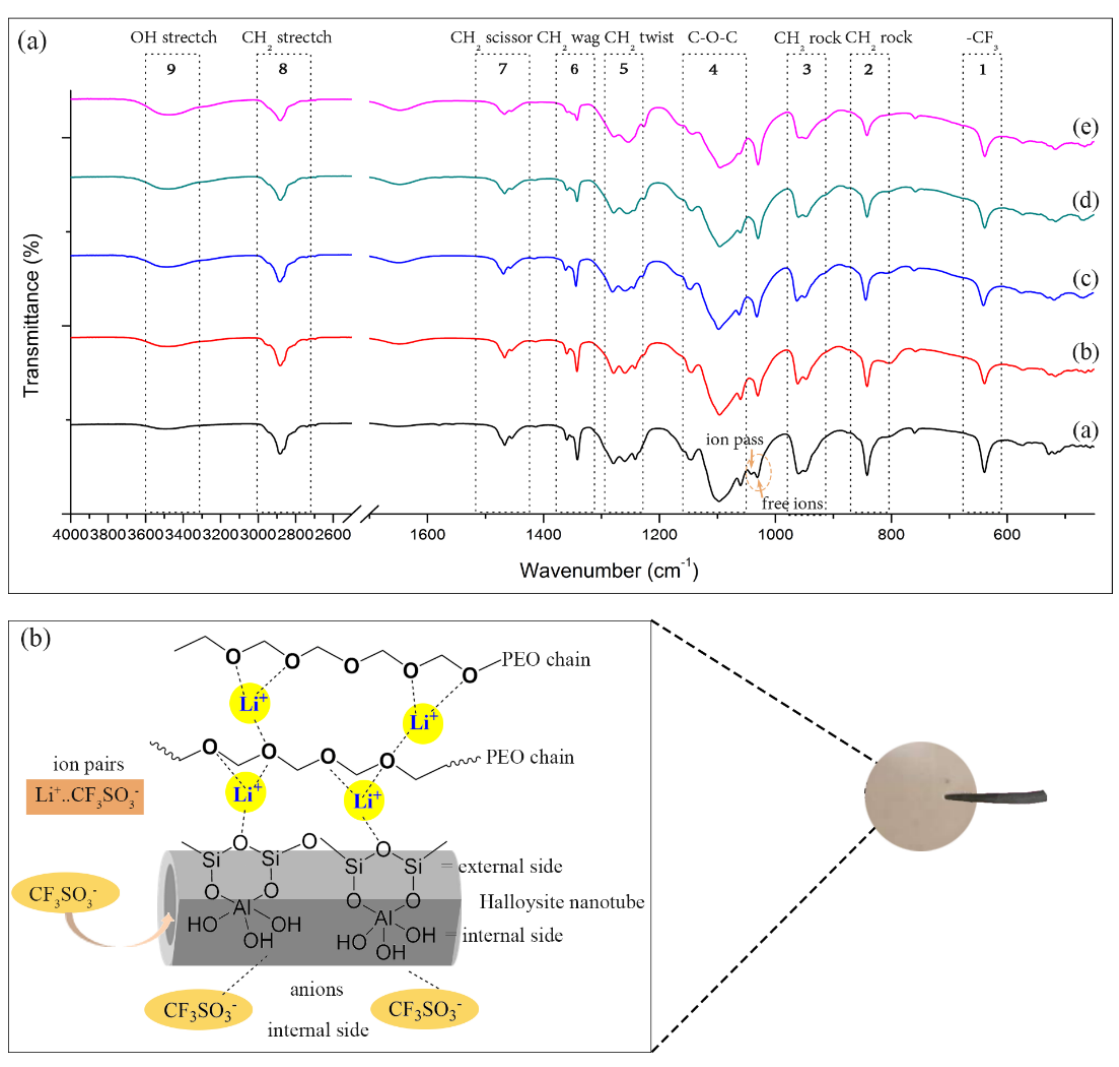
Figure 8. ( a ) ATR − FTIR spectra in the region of 450–4000 cm − 1 of (a) PEO − 20%LiCF 3 SO 3 , (b) PEO − 20%LiCF 3 SO 3 − 5%HNT, (c) PEO − 20%LiCF 3 SO 3 − 5%HNT − 15 min, (d) PEO − 20%LiCF − 5%HNT − 30 min, and (e) PEO − 20%LiCF − 5%HNT − 60 min. ( b ) Schematic illustration of Li + conduction mechanism in PEO − LiCF 3 SO 3 − HNT (left) and the sample of solid polymer electrolyte